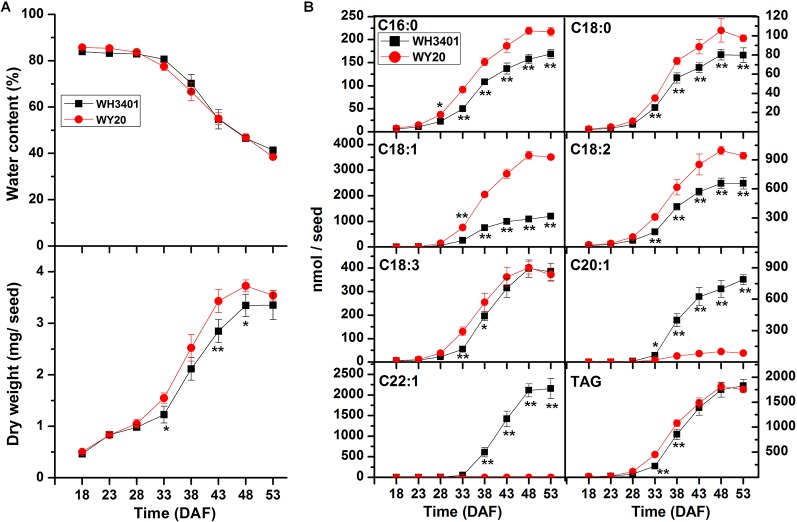
Characterization of seed development of WH3401 and WY20. (A) Water content and seed weight (dry weight) during seed development. Data of seed water content and seed weight are the means ± SD of 5 individual plants. (B) Fatty acid accumulation during seed development. Data of fatty acid content are the means ± SD of 6 individual plants. DAF, days after flowering. * and ** denote significant difference at P < 0.05 and P < 0.01, respectively, based on Student's t test.